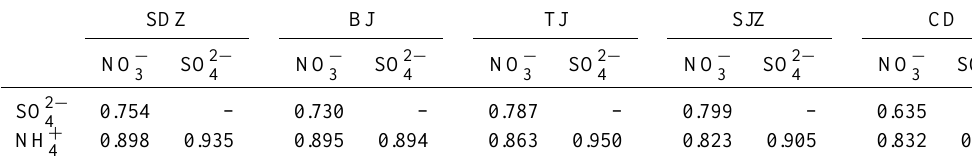
, NO − , and SO 2 − at each site. 4 3 4